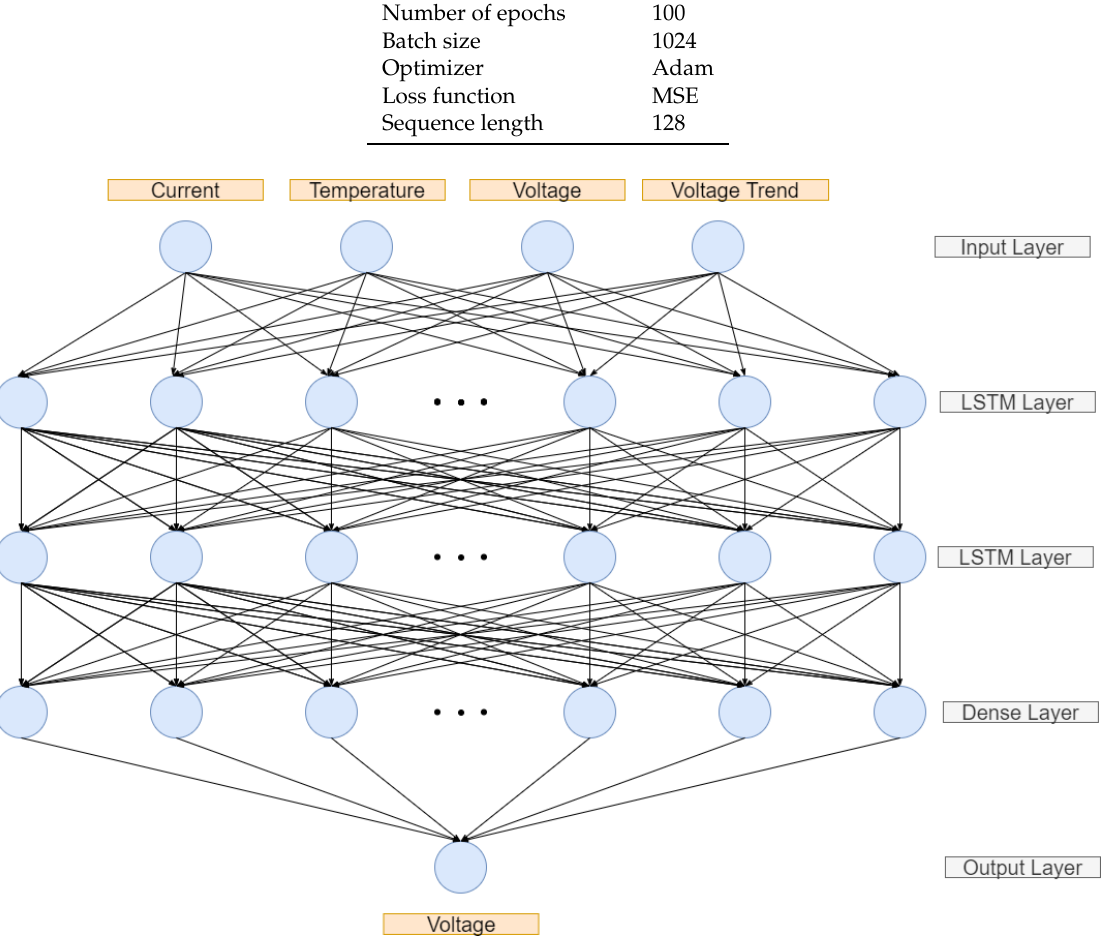
Figure 4. Proposed model